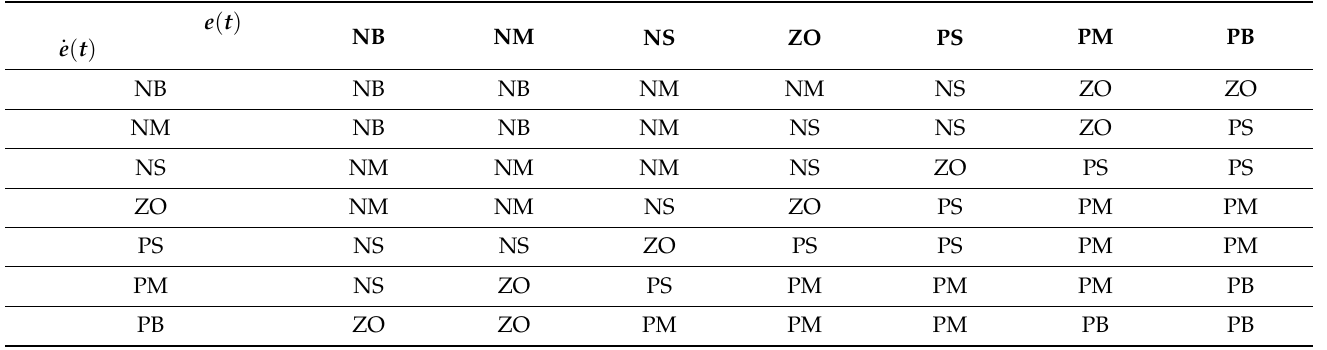
Table 1. Fuzzy control rules for the